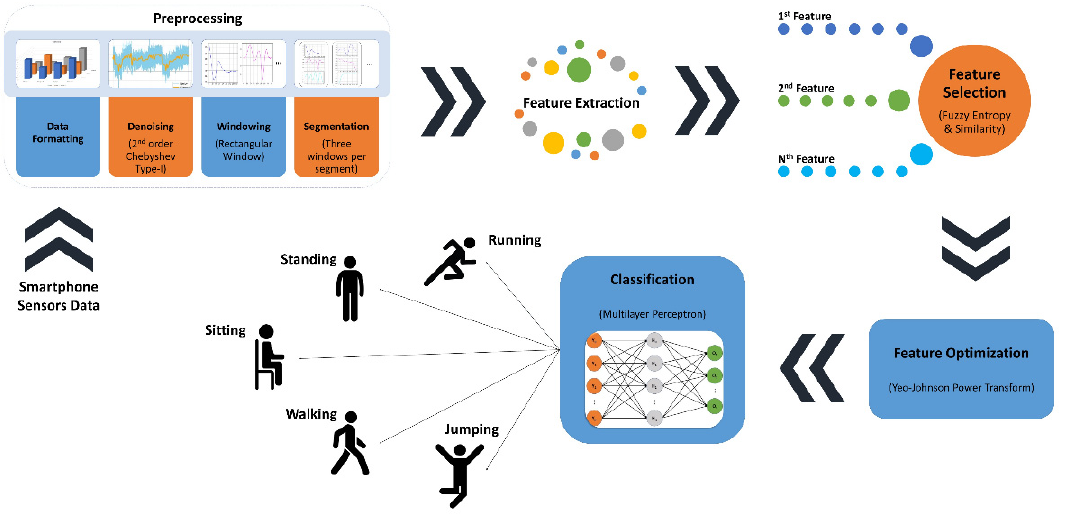
Figure 1. The architecture of the proposed smartphone sensors remote data classification (SSRDC) system.